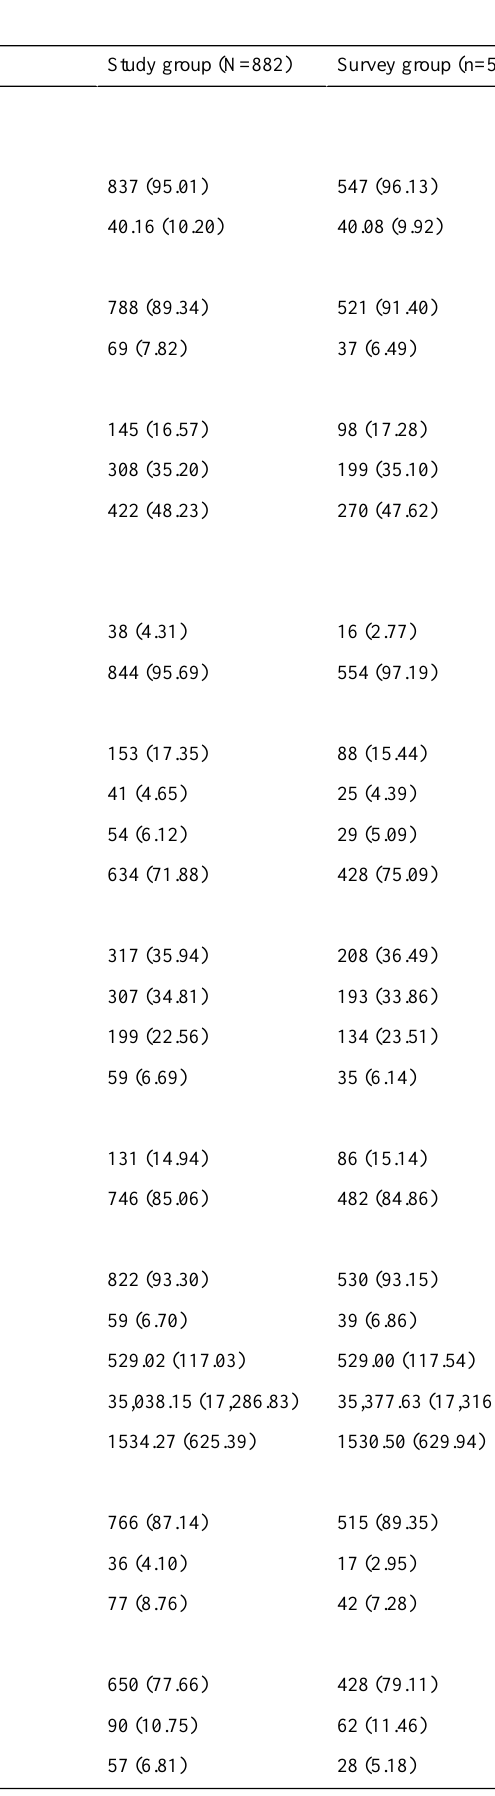
Table 1. Baseline characteristics of caregivers and veterans dyads